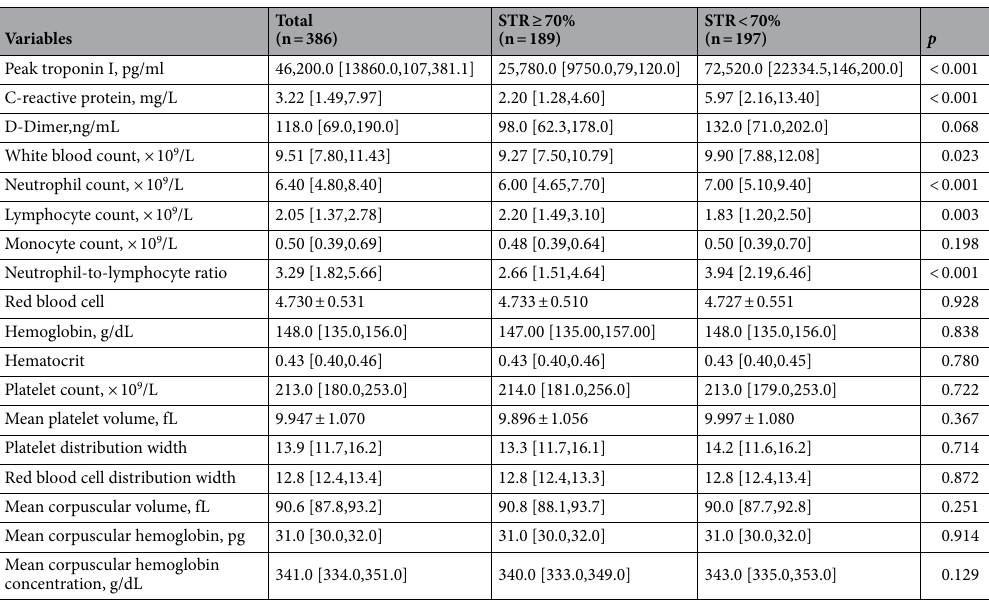
Table 2. The admission laboratory results according to STR